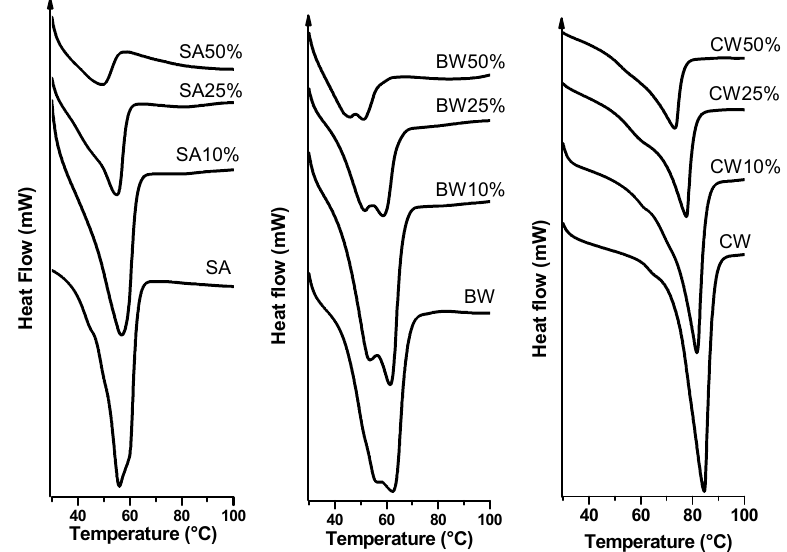
Figure 2. Differential scanning calorimetry curves of the stearic acid (left, SA), beeswax (middle, BW) and carnauba wax (right, CW), in comparison to their binary mixtures containing 10%, 25% and 50% of carvacrol (see Table 1 for composition).